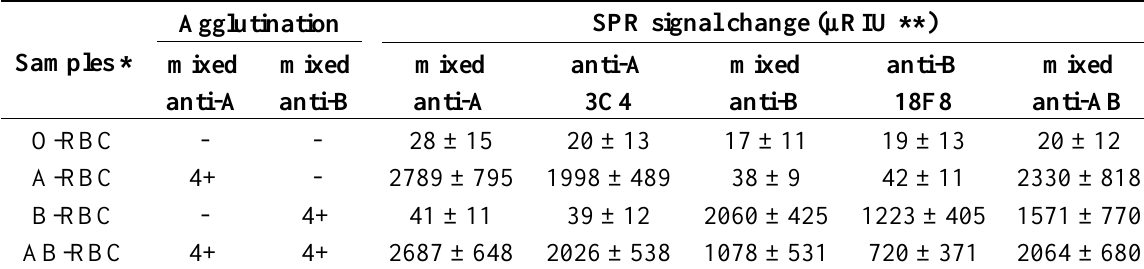
Table 1. ABO blood type results using the agglutination and SPR imaging techniques. Two groups of detection antibodies were used in the agglutination test. For the SPR imaging test, five groups of detection antibodies were